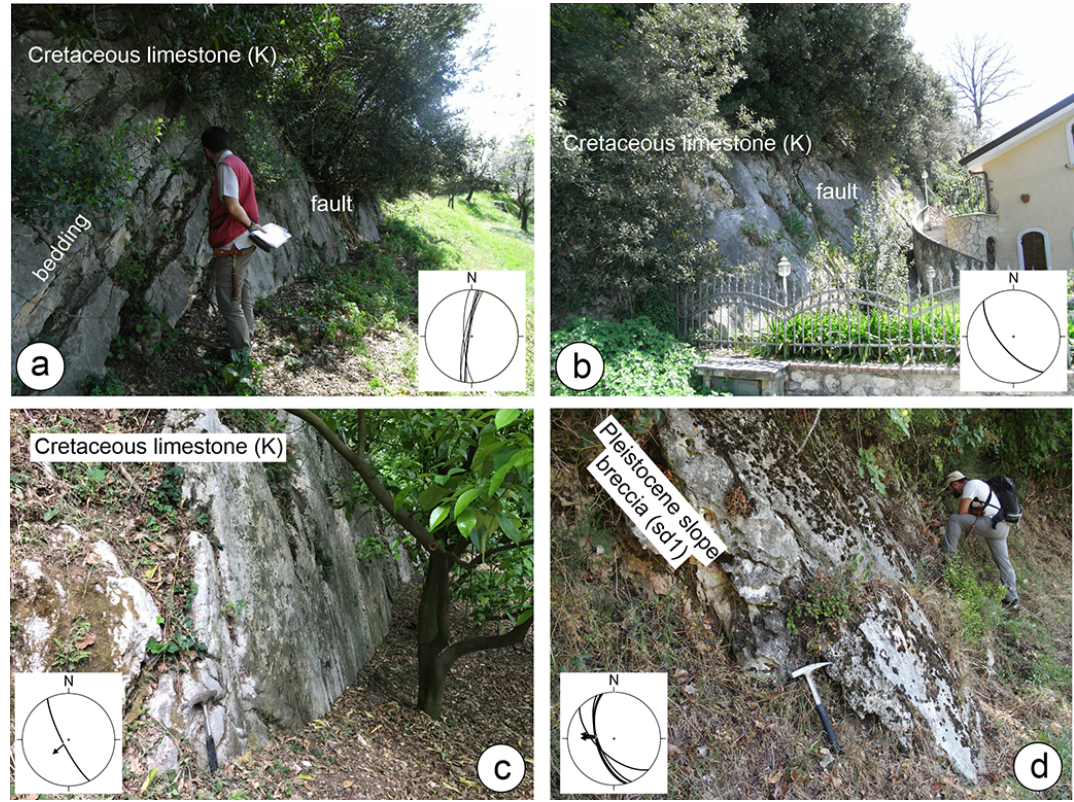
Figure 5. Field view of the Gioia Sannitica normal fault on carbonate bedrock ( a–c ; San Potito fault section) and on Quaternary breccia ( c ; Castello di Gioia fault section). The location of these images is marked in Fig.